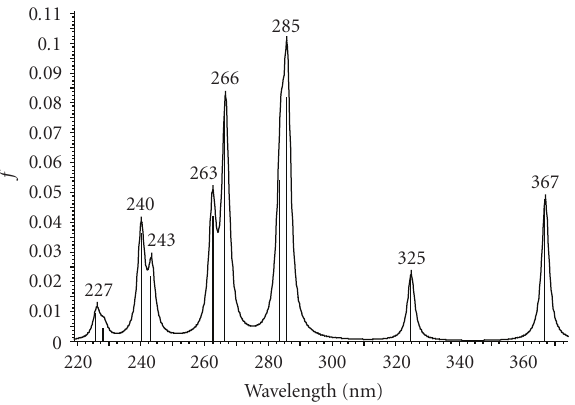
Figure 3: UV-Vis spectrum of the TSO molecule calculated with the CHIH-DFT(small) model